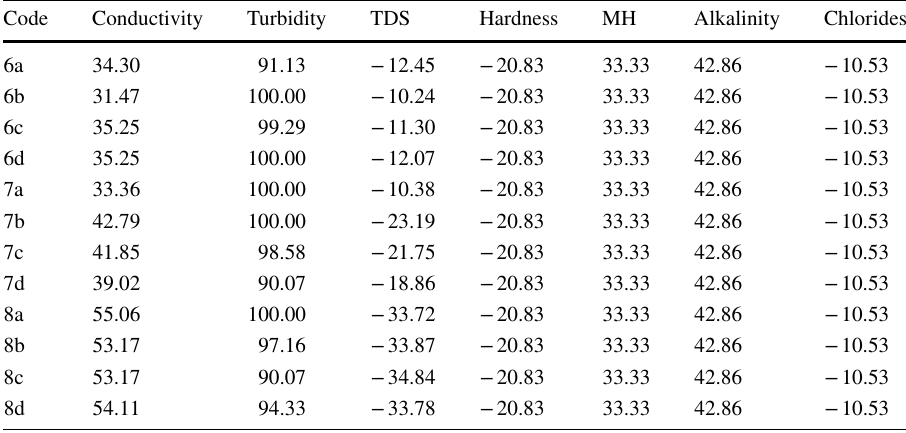
in various physicochemical parameters of surface water after treatment with blended coagulant (alum +